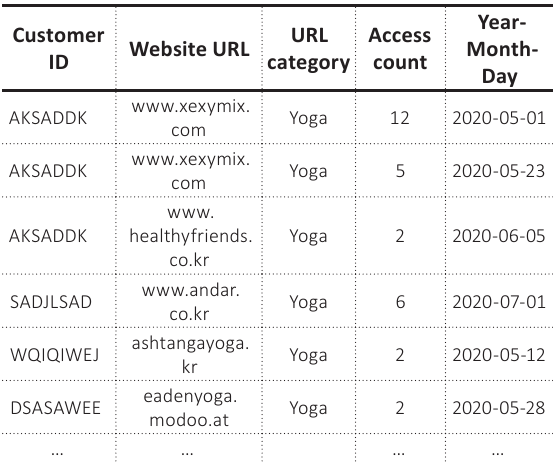
Table 1. Partial website access data